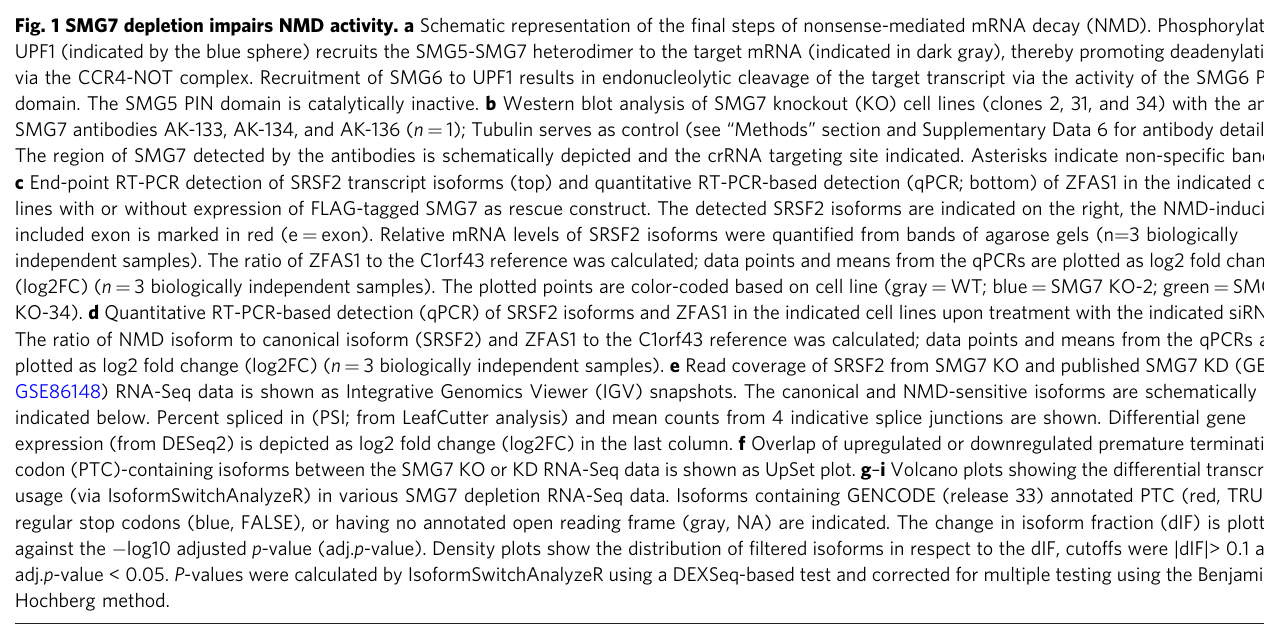
Fig. 1 SMG7 depletion impairs NMD activity. a Schematic representation of the fi nal steps of nonsense-mediated mRNA decay (NMD). Phosphorylated UPF1 (indicated by the blue sphere) recruits the SMG5-SMG7 heterodimer to the target mRNA (indicated in dark gray), thereby promoting deadenylation via the CCR4-NOT complex. Recruitment of SMG6 to UPF1 results in endonucleolytic cleavage of the target transcript via the activity of the SMG6 PIN domain. The SMG5 PIN domain is catalytically inactive. b Western blot analysis of SMG7 knockout (KO) cell lines (clones 2, 31, and 34) with the anti- SMG7 antibodies AK-133, AK-134, and AK-136 ( n = 1); Tubulin serves as control (see “ Methods ” section and Supplementary Data 6 for antibody details). The region of SMG7 detected by the antibodies is schematically depicted and the crRNA targeting site indicated. Asterisks indicate non-speci fi c bands. c End-point RT-PCR detection of SRSF2 transcript isoforms (top) and quantitative RT-PCR-based detection (qPCR; bottom) of ZFAS1 in the indicated cell lines with or without expression of FLAG-tagged SMG7 as rescue construct. The detected SRSF2 isoforms are indicated on the right, the NMD-inducing included exon is marked in red (e = exon). Relative mRNA levels of SRSF2 isoforms were quanti fi ed from bands of agarose gels (n = 3 biologically independent samples). The ratio of ZFAS1 to the C1orf43 reference was calculated; data points and means from the qPCRs are plotted as log2 fold change (log2FC) ( n = 3 biologically independent samples). The plotted points are color-coded based on cell line (gray = WT; blue = SMG7 KO-2; green = SMG7 KO-34). d Quantitative RT-PCR-based detection (qPCR) of SRSF2 isoforms and ZFAS1 in the indicated cell lines upon treatment with the indicated siRNA. The ratio of NMD isoform to canonical isoform (SRSF2) and ZFAS1 to the C1orf43 reference was calculated; data points and means from the qPCRs are plotted as log2 fold change (log2FC) ( n = 3 biologically independent samples). e Read coverage of SRSF2 from SMG7 KO and published SMG7 KD (GEO: GSE86148) RNA-Seq data is shown as Integrative Genomics Viewer (IGV) snapshots. The canonical and NMD-sensitive isoforms are schematically indicated below. Percent spliced in (PSI; from LeafCutter analysis) and mean counts from 4 indicative splice junctions are shown. Differential gene expression (from DESeq2) is depicted as log2 fold change (log2FC) in the last column. f Overlap of upregulated or downregulated premature termination codon (PTC)-containing isoforms between the SMG7 KO or KD RNA-Seq data is shown as UpSet plot. g – i Volcano plots showing the differential transcript usage (via IsoformSwitchAnalyzeR) in various SMG7 depletion RNA-Seq data. Isoforms containing GENCODE (release 33) annotated PTC (red, TRUE), regular stop codons (blue, FALSE), or having no annotated open reading frame (gray, NA) are indicated. The change in isoform fraction (dIF) is plotted against the − log10 adjusted p -value (adj. p -value). Density plots show the distribution of fi ltered isoforms in respect to the dIF, cutoffs were |dIF|> 0.1 and adj. p -value < 0.05. P -values were calculated by IsoformSwitchAnalyzeR using a DEXSeq-based test and corrected for multiple testing using the Benjamini- Hochberg